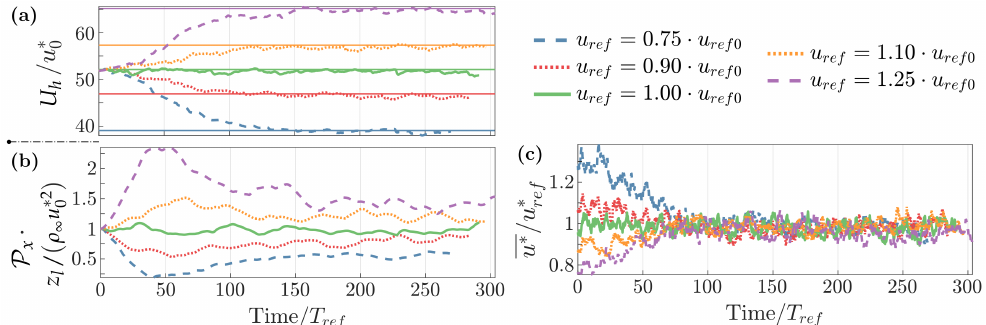
Figure 5. Time histories of non-dimensional: ( a ) wind speed at S z + , with target values denoted in the horizontal lines; ( b ) large-scale pressure gradient; ( c ) friction velocity. Averaged with t avg = 75 × 10 − 3 T 0 . Flat-bottom application.